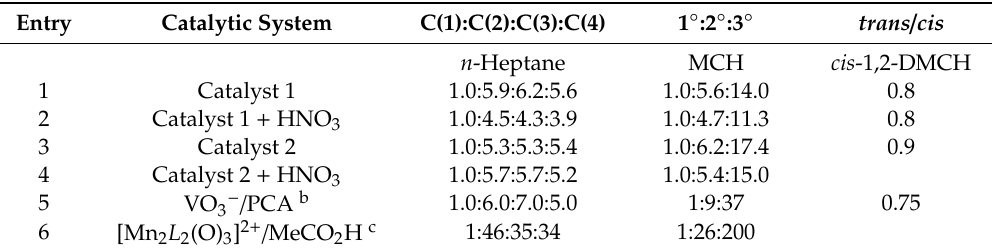
Table 1. Selectivity parameters in H 2 O 2 oxidations of alkanes by certain catalytic systems a